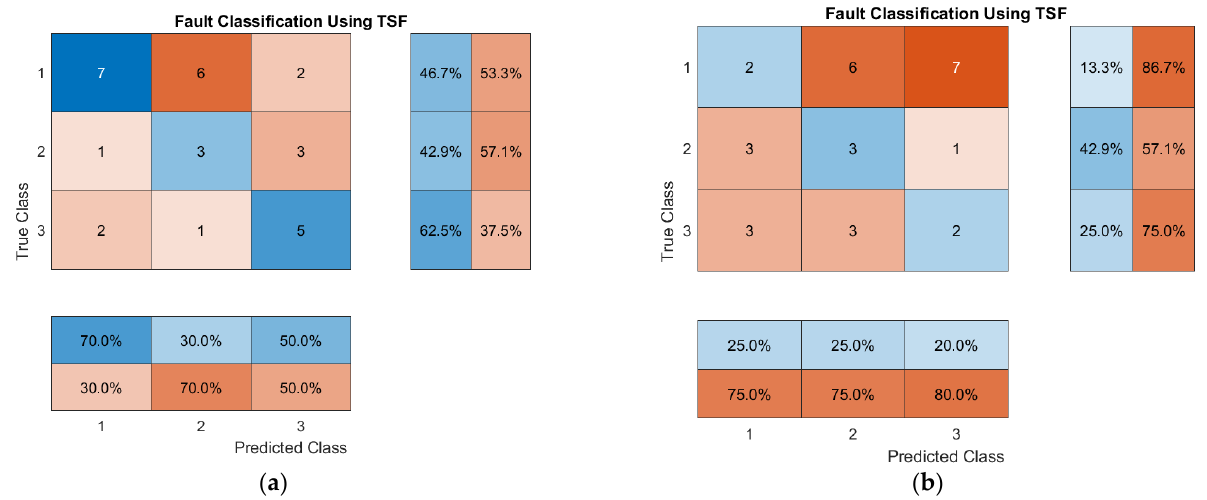
Figure 11. Confusion Matrix for TSF Model: ( a ) Case 1 — Most-Accurate Iteration; ( b ) Case 2 — Least-Accurate Iteration.